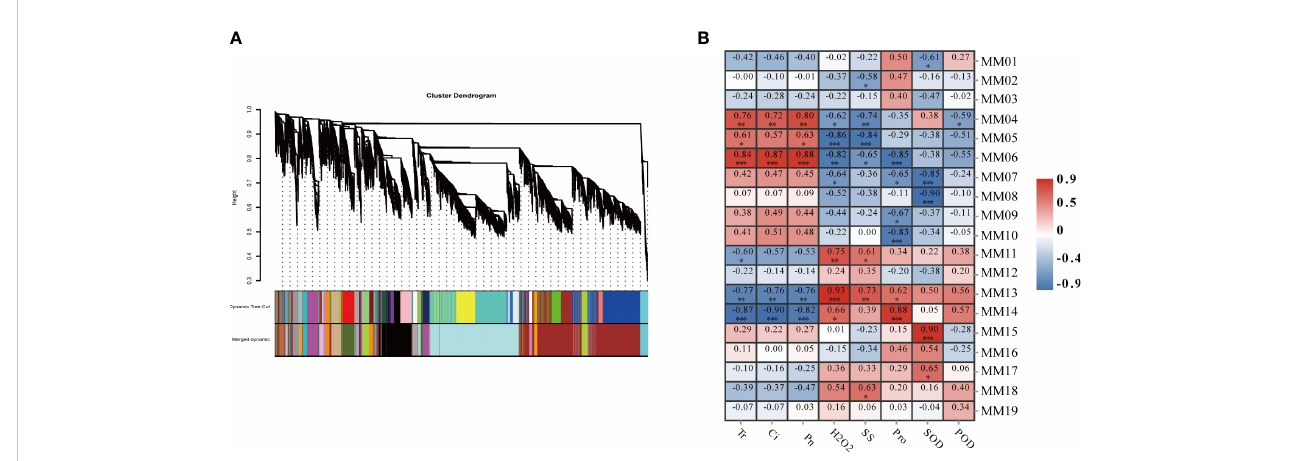
FIGURE 5 Weighted gene co-expression network analysis (WGCNA) of effectively expressed genes under LD and HD treatment. (A) Hierarchical cluster tree showing co-expression modules identi fi ed by WGCNA. Each leaf in the tree represents one gene. The major tree branches constitute 19 modules labeled with different colors; (B) Correlation analysis between gene co-expression network modules and physiological indices. The horizontal axis represents different physiological traits, and the vertical axis represents the module eigengenes in each module. Each frame contains the corresponding correlations and P values. * P <0.05, ** P <0.01, *** P